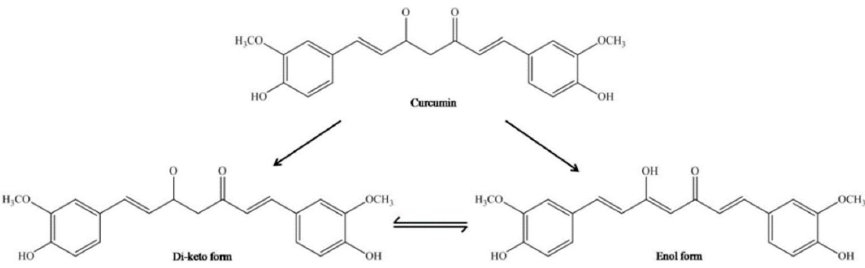
Figure 3. Chemical structure of enol and keto tautomeric forms of CUR molecule [61].